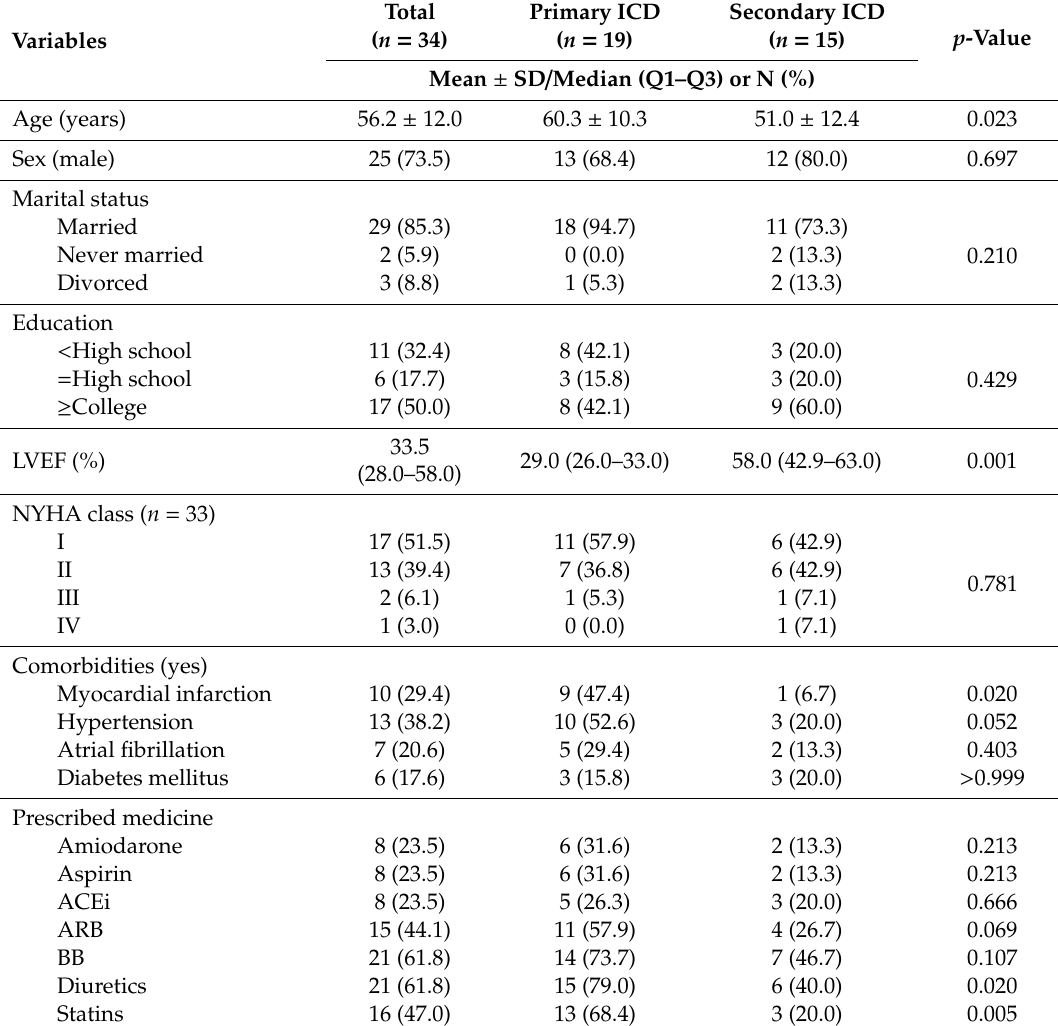
Table 1. Baseline Demographic and Disease-related Characteristics of Patient